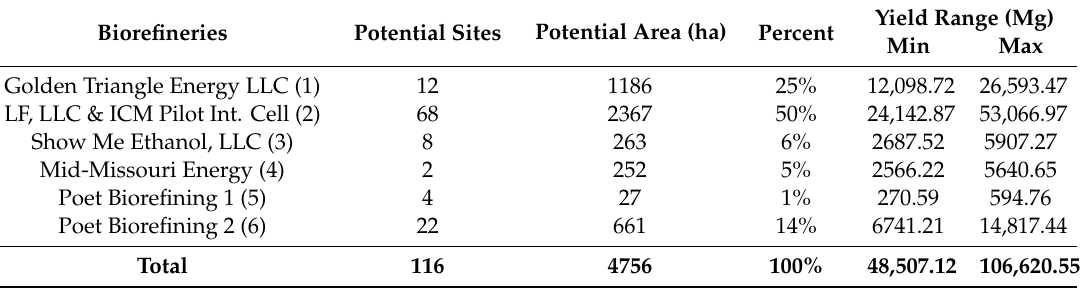
Table 7. Potential feedstock by biorefinery in scenario 2.